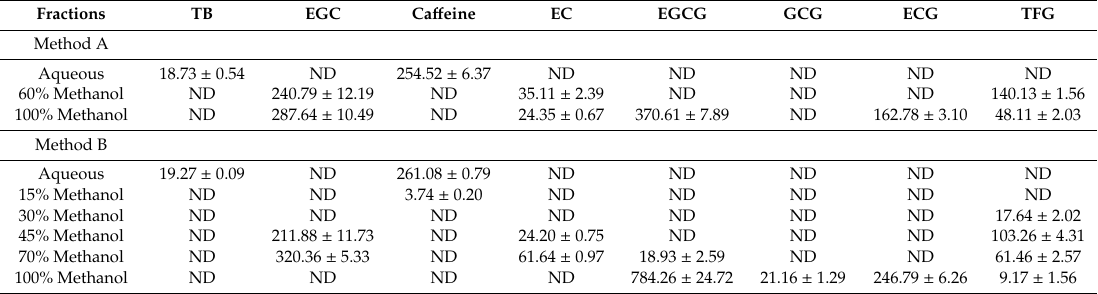
Table 1. The e ff ect of elution method on the chemical composition of di ff erent fractions ( µ g / mL). Table 1. The effect of elution method on the chemical composition of different fractions ( μ g/mL).